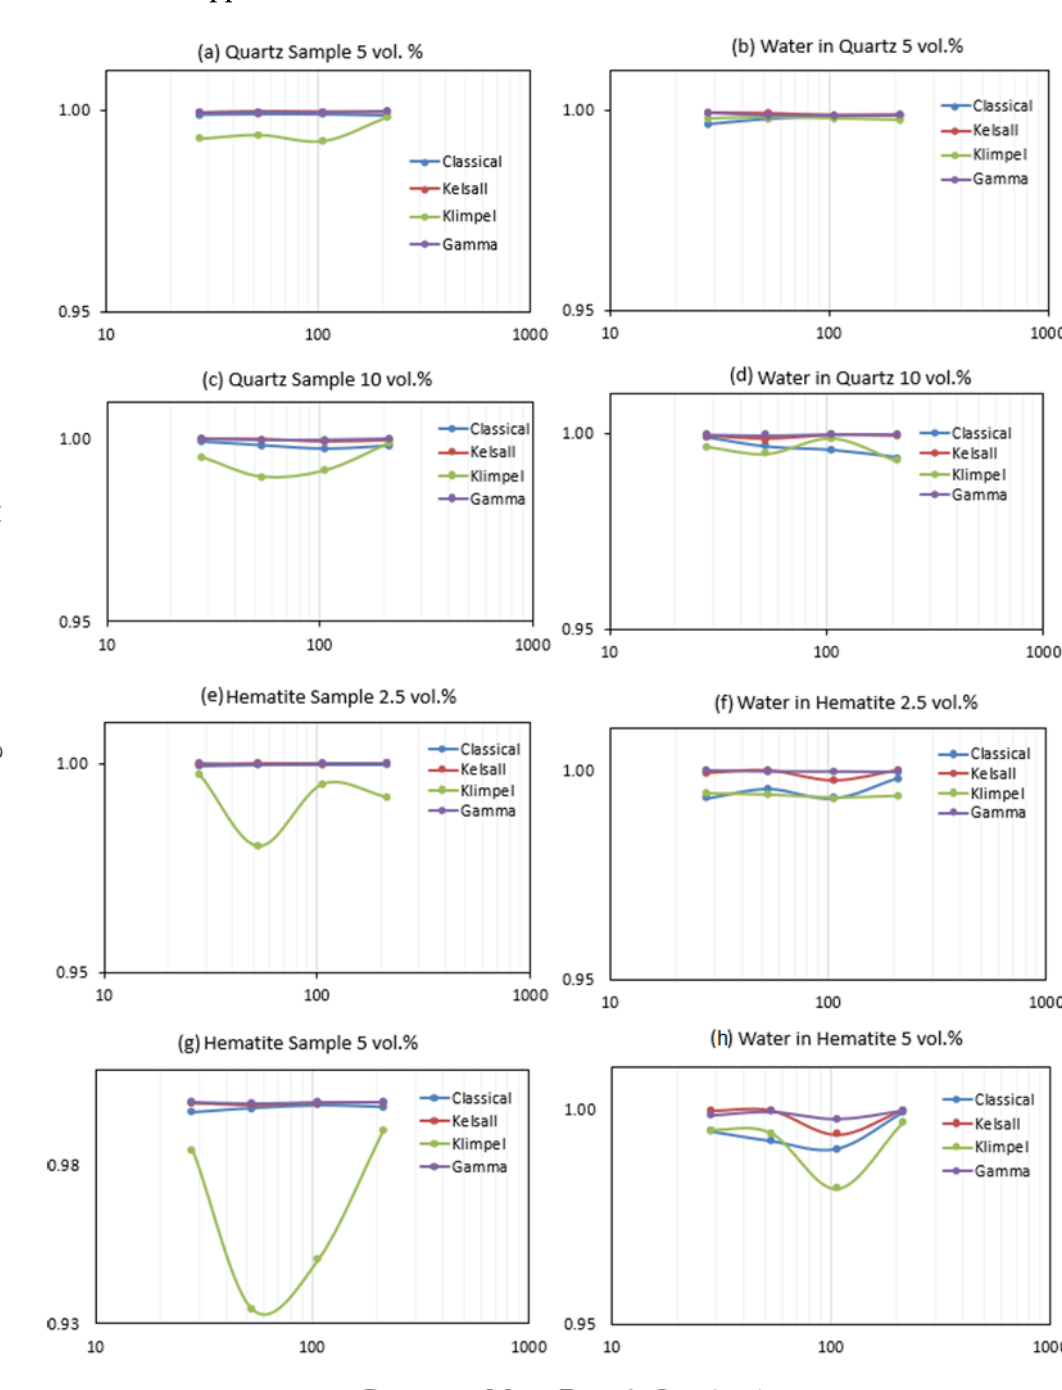
Figure A1. Model fitting using the non-linear regression coefficient: ( a ) quartz 5 vol.% ( b ) water in quartz 5 vol.%, ( c ) quartz sample 10 vol.%, ( d ) water in quartz 10 vol.%, ( e ) hematite sample 2.5